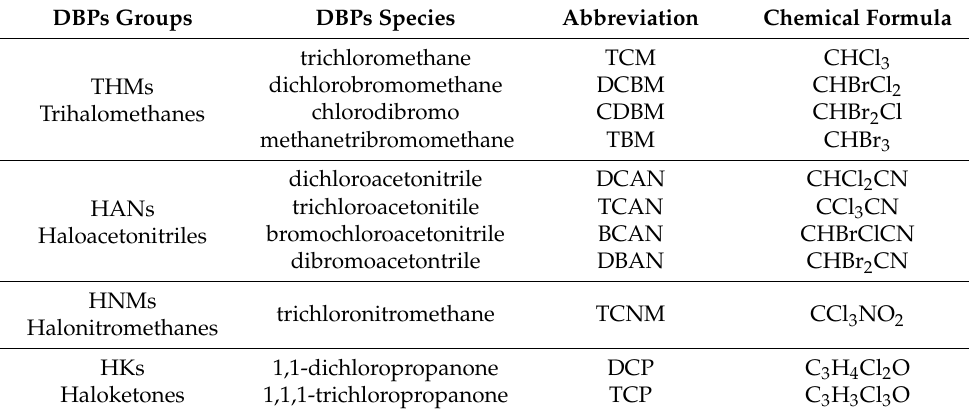
Table 1. DBPs groups determined in this